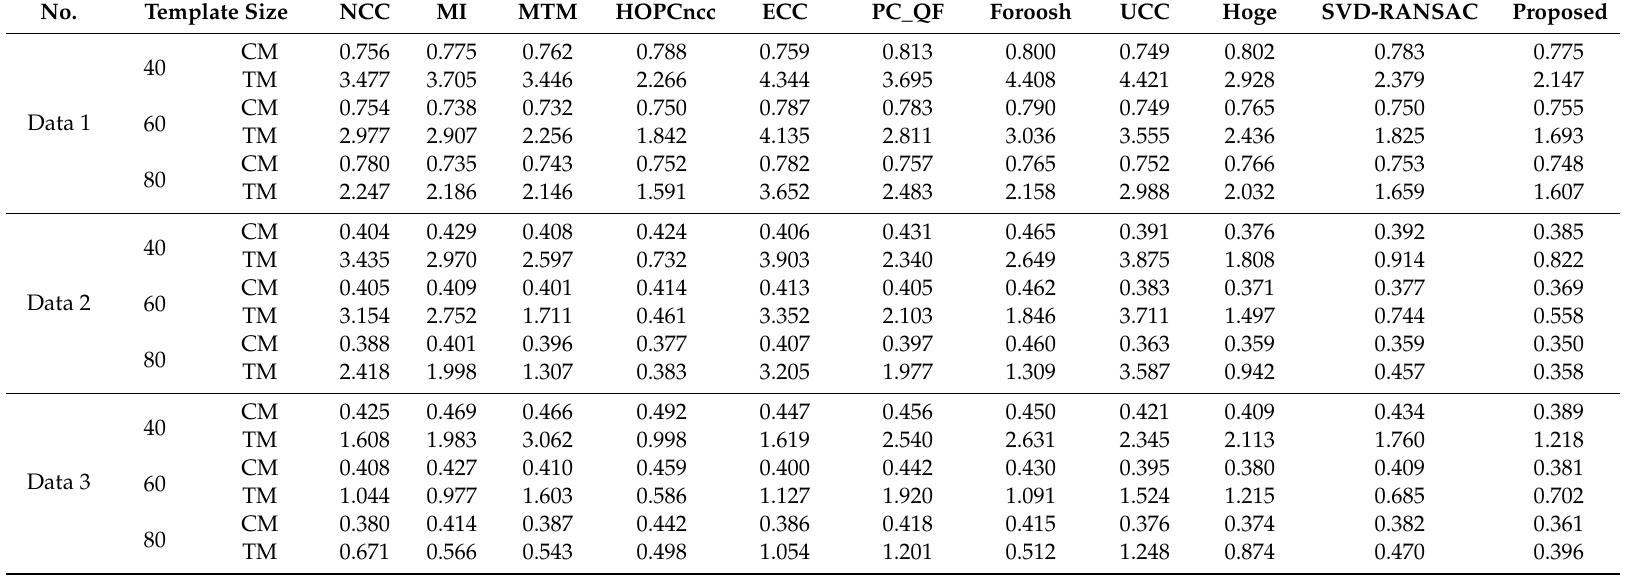
Table 3. RMSEs of the correct matches (CM) and total matches (TM) of various matching methods with three di ff erent template sizes (unit: pixels).